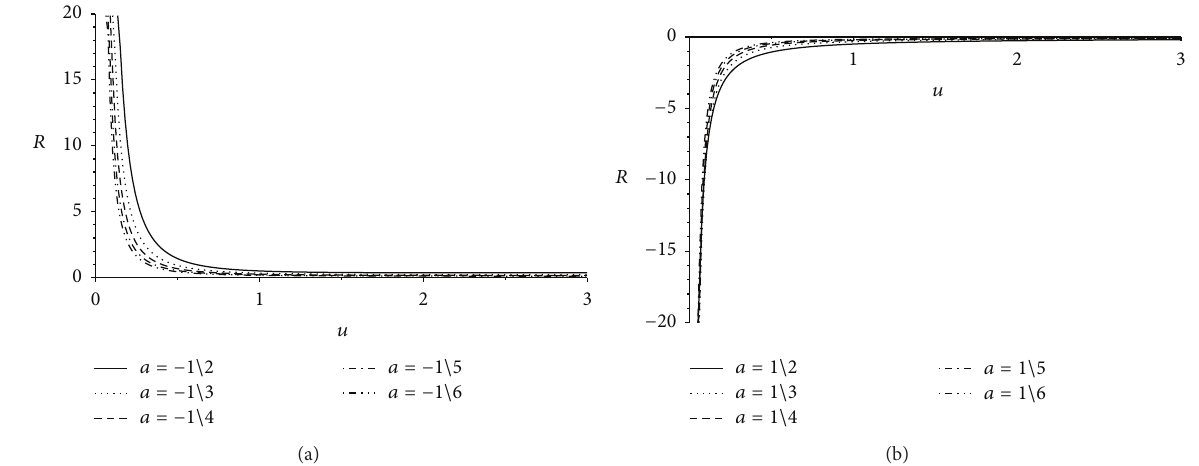
Figure 2: These plots correspond to the radial function for −1 ≤ 𝛼 ≤ 1 . We observe that only those values of 𝛼 < 0 can be associated with physical